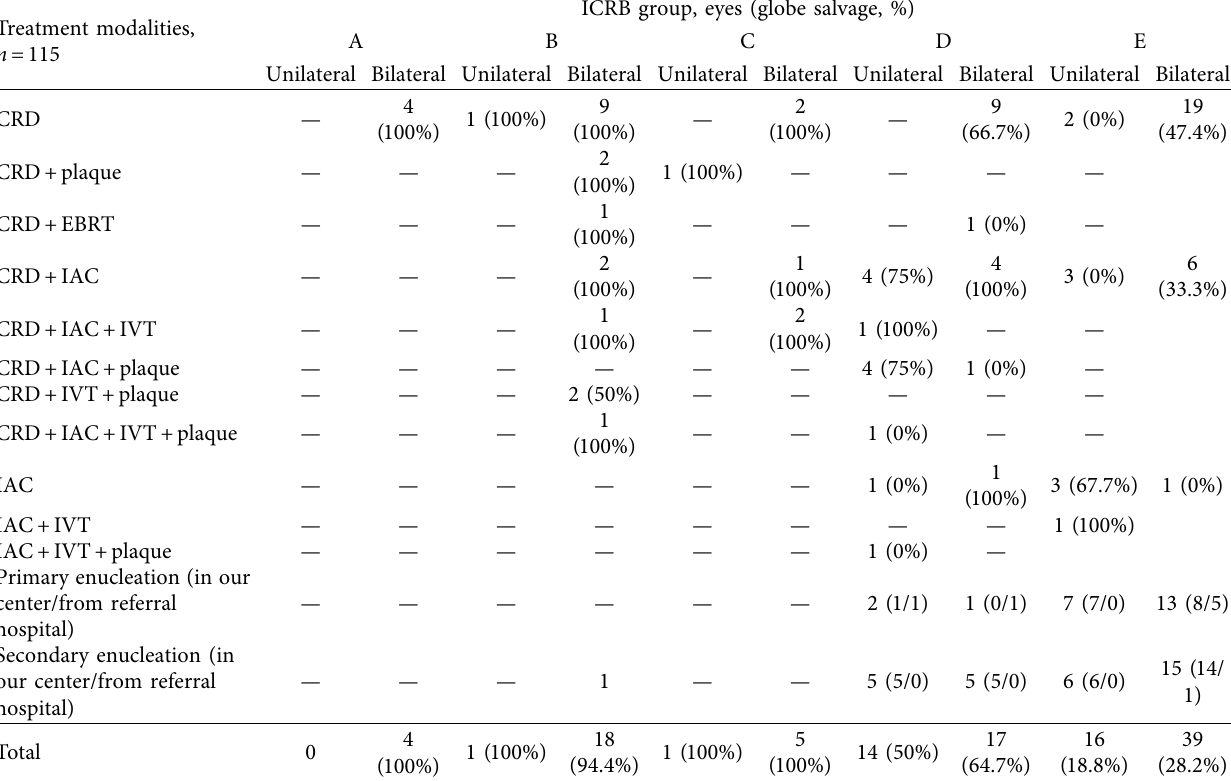
Table 2: Treatment modalities and globe salvage rates for intraocular tumor according to International Classification of Retinoblastoma (ICRB). Treatment modalities, n � 115